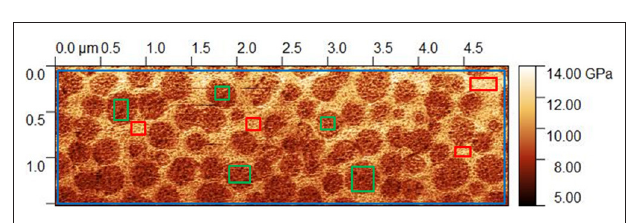
FIGURE 4 | PF-QNM mapping of indentation modulus for Ag 15 (Ge 0.25 Se 0.75 ) 85 glass. The blue, red and green regions correspond to the average (or macroscopic) indentation modulus, the R-Agx phase and the P-Agx phase modulus,